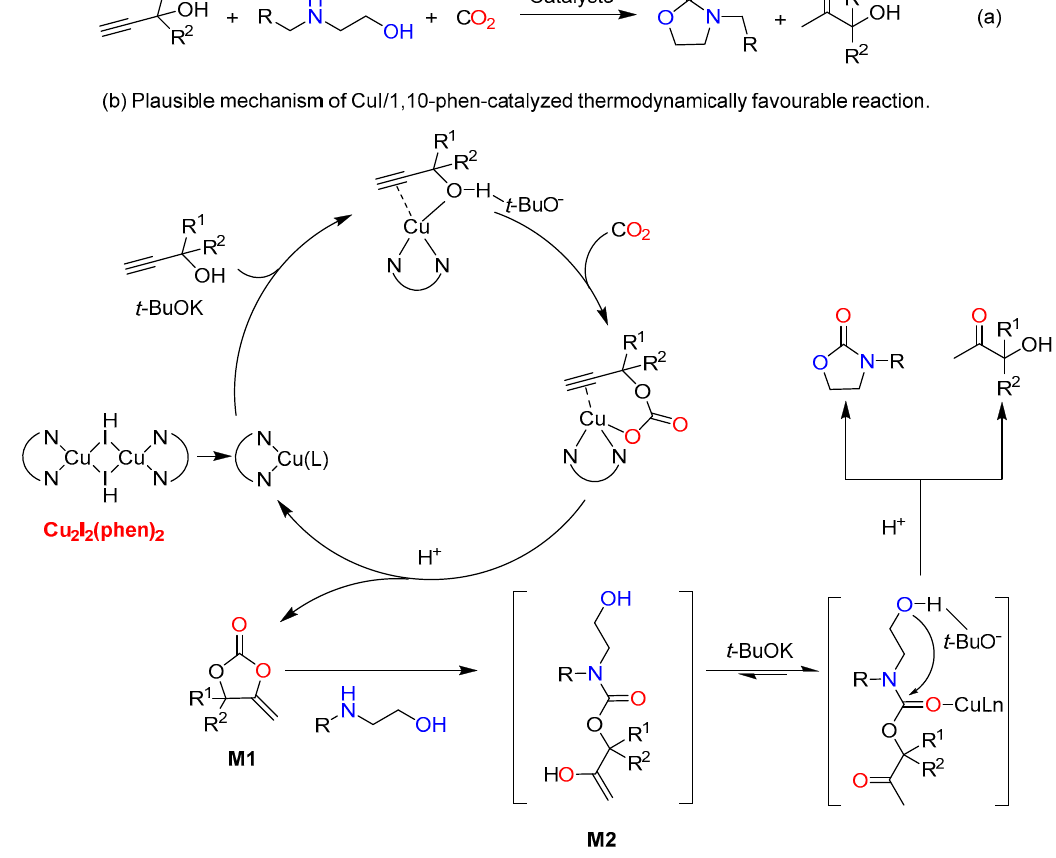
Table 2. One-pot three-component reactions of propargylic alcohols, CO 2 and 2-aminoethanols. Catalyst (Catalytic Amount/mol%) Solvent T/ ◦ C P/MPa t/h